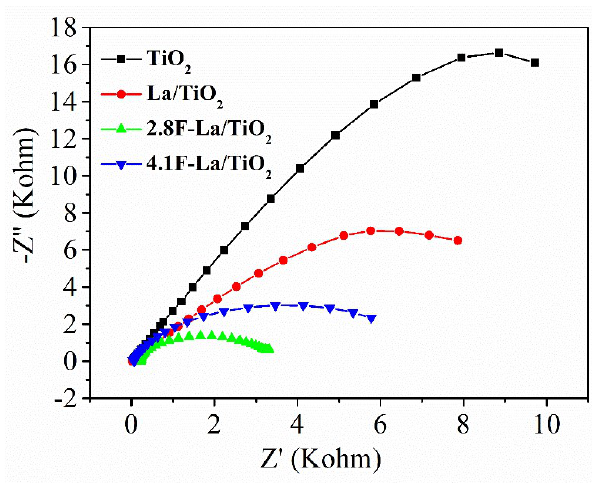
Figure 5. Electron transfer efficiency of investigated photocatalysts.